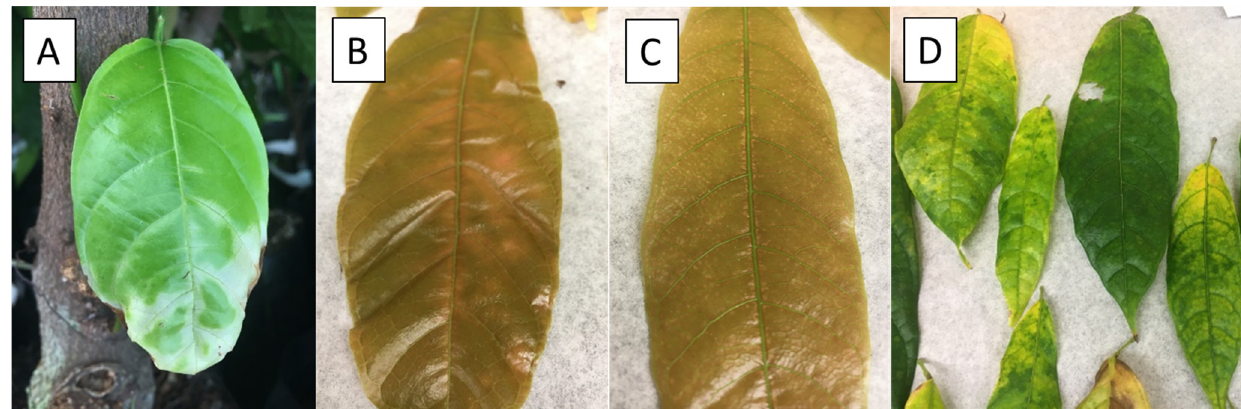
Figure 1. Cacao ( Theobroma cacao L.) leaves observed in September 2020 with virus symptoms such as ( A ) white vein banding ( B ) red vein banding ( C ) flecking ( D ) mosaic.